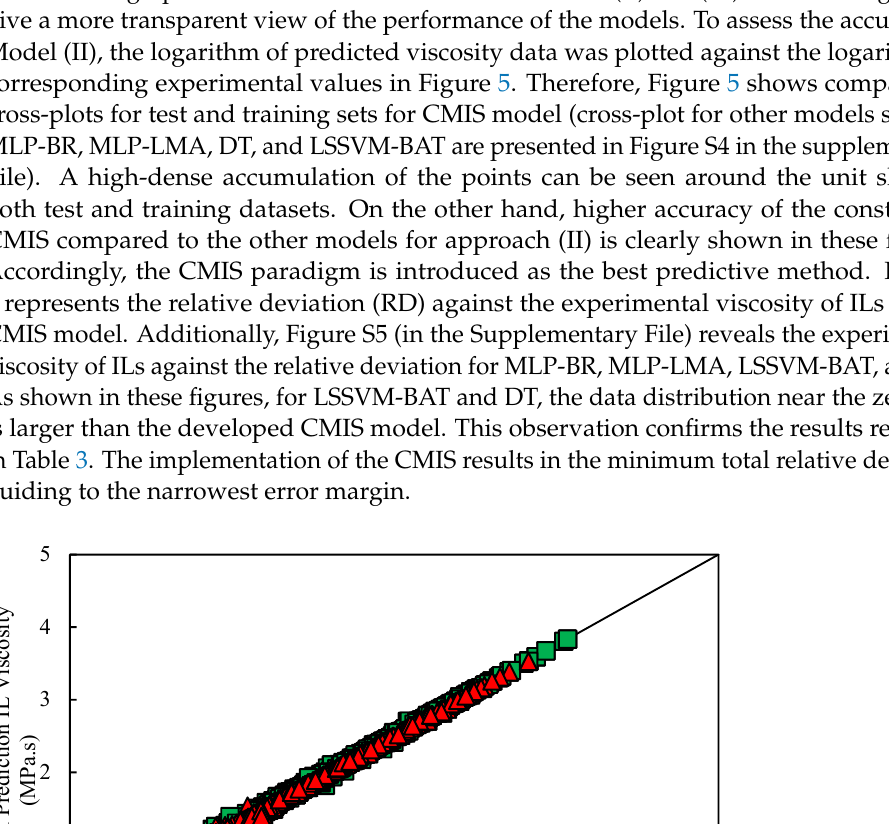
Figure 6. Relative deviation of prediction of CMIS model versus logarithm of experimental data based on Model (II). Furthermore, Figure 7 is plotted to assess the capability of the models with respect to the AARD (%) of the proposed empirical correlation (Equation (42)), smart models devel- oped based on Model (II), Eyring’s theory in this study, and also other models form the literature. Clearly, the CMIS model and then the MLP-BR approach are more accurate, have a higher flexibility, and are more suitable to be used for the viscosity prediction of ILs approach. Figure 8 depicts the data cumulative frequency versus the ARD for the MLP-LMA, MLP-BR, LSSVM-BAT, DT, and CMIS models. As shown in this figure, the